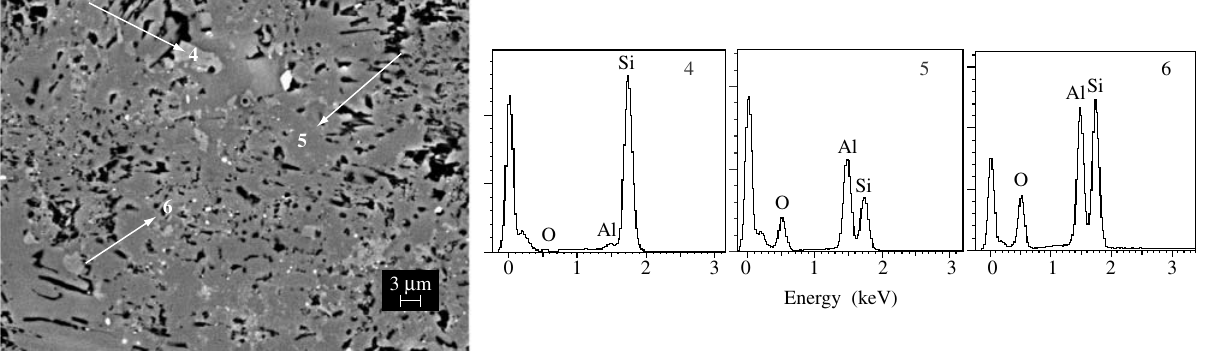
Figure 6. SEM micrograph of the sample pyrolysed at 1600 °C/1 h using back scattered electrons showing regions with differences in elemental composition, according to the